Question: What does this figure show? Answer in one sentence.
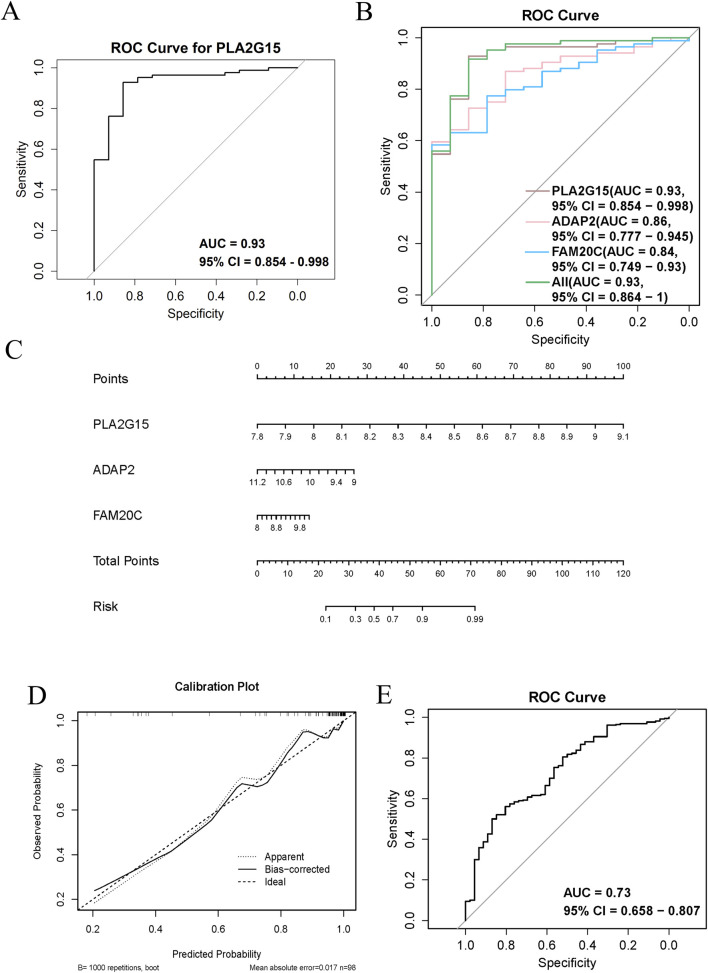
Answer: Evaluation of the diagnostic value of core genes and construction of the diagnostic model. (A) ROC curves for individual core genes PLA2G15 in the GSE62646 training set. (B) ROC curve of the multivariable logistic regression combined diagnostic model based on ADAP2, FAM20C, and PLA2G15 in the GSE62646 training set. (C) Nomogram for predicting the risk probability of AMI using the core genes. (D) Calibration curve of the nomogram. (E) ROC curve of the combined diagnostic model in the GSE59867 validation set.